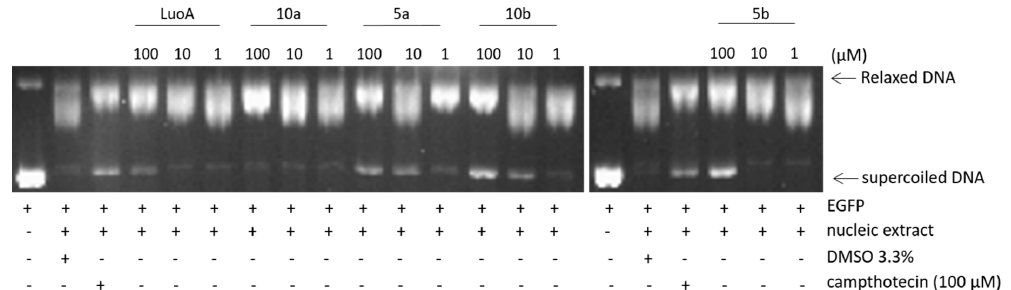
Figure 4. Effects of examined compounds on relaxation of supercoiled EGFP plasmid DNA by Top1.